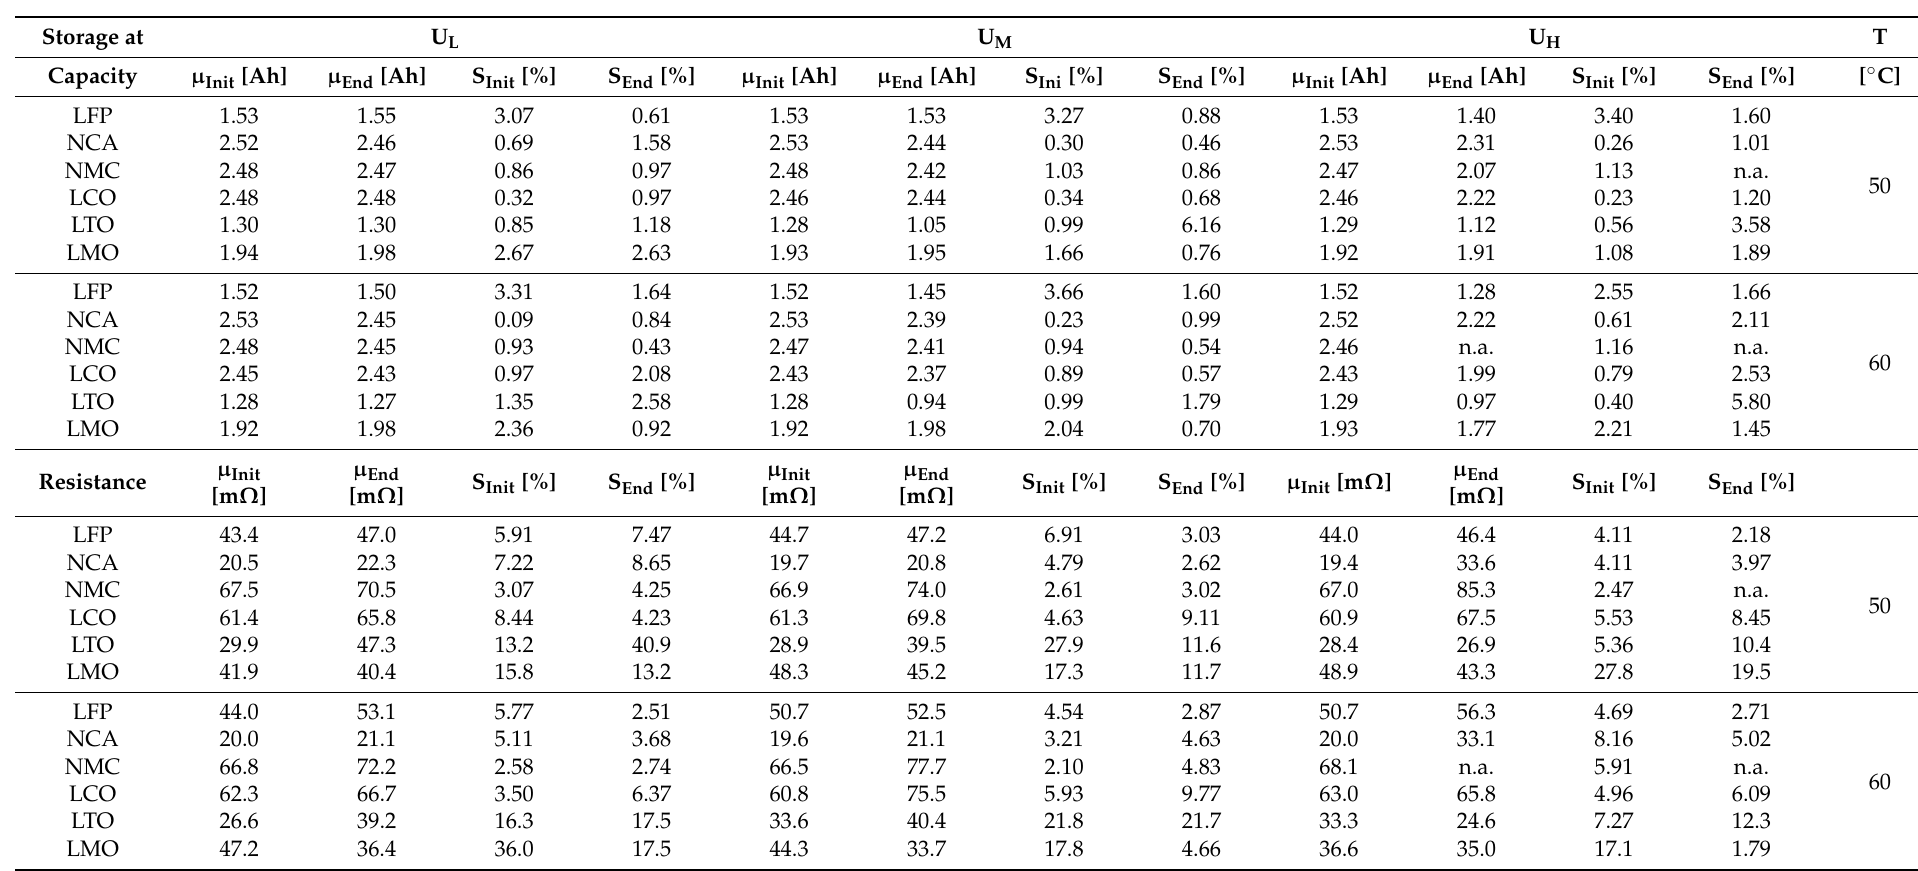
Table 3. Comparison of the initial and end capacity and discharge resistance values of the expected value and standard deviation of all cells aged at 50 ◦ C and 60 ◦ C, grouped into the three storage voltage groups, respectively; the sample number n of LFP, NCA, NMC and LCO cells is 11 for each voltage, 6 for LTO and 5 for LMO, limited by the supply of cells at that time. Storage at U